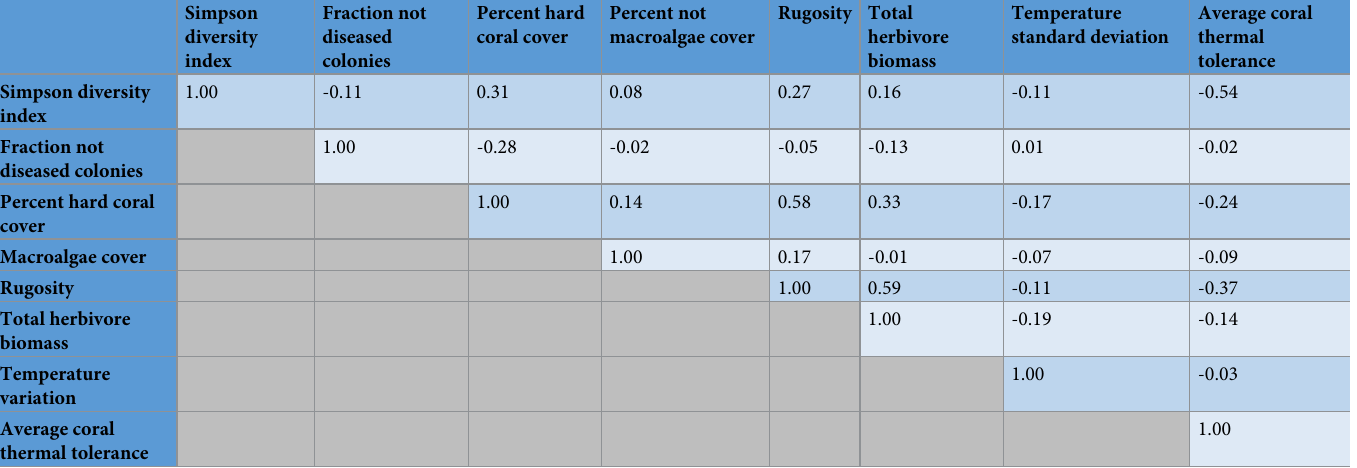
Table 3. Spearman rank correlation coefficients between resilience indicators at 103 survey sites.